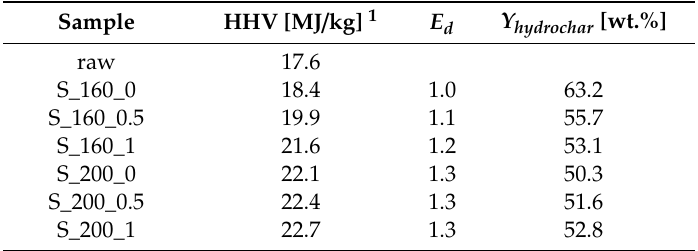
Table 3. Higher heating value (HHV), energy density ( E d ) and total yield ( Y hydrochar ) of the hydrochars and raw material.